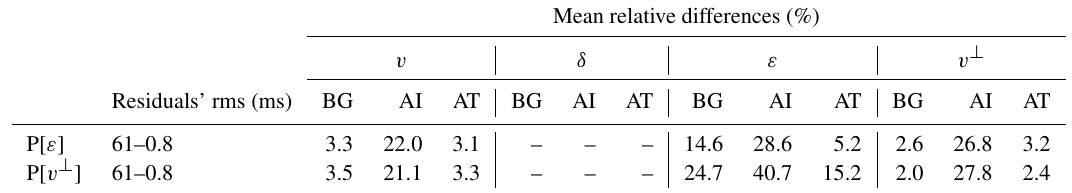
Table 8. Same as Table 4 but for the simultaneous inversion of P[ ε ] and P[ v ⊥ ] following Eq. (1), i.e., neglecting δ in Eqs. (1) and (3). Model differences for v , ε and v ⊥ , as well as data misfit, are all significantly worse than for any of the previous tests. Mean relative differences